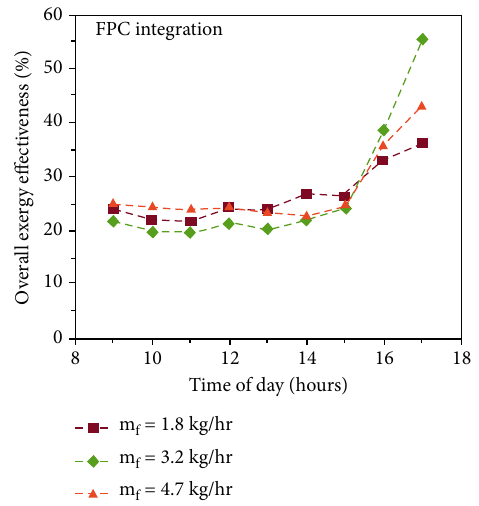
Figure 18: E ff ect of water mass fl ow rate on the overall exergy e ffi ciency during a day